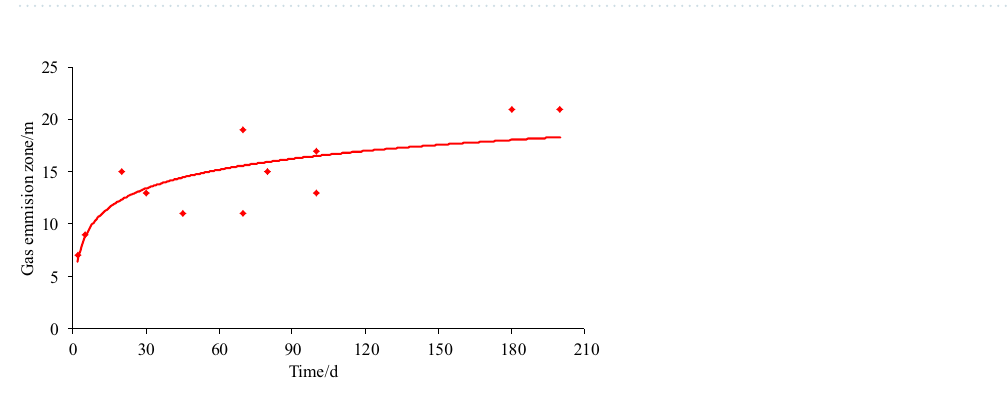
Figure 12. The variation rule of gas emission zone with